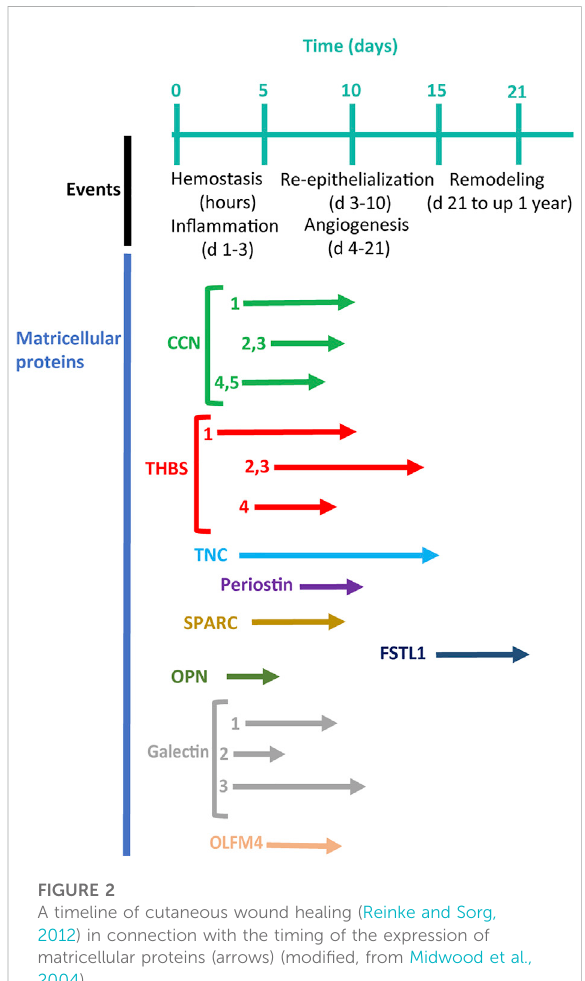
FIGURE 2 A timeline of cutaneous wound healing (Reinke and Sorg, 2012) in connection with the timing of the expression of matricellular proteins (arrows) (modi fi ed, from Midwood et al.,